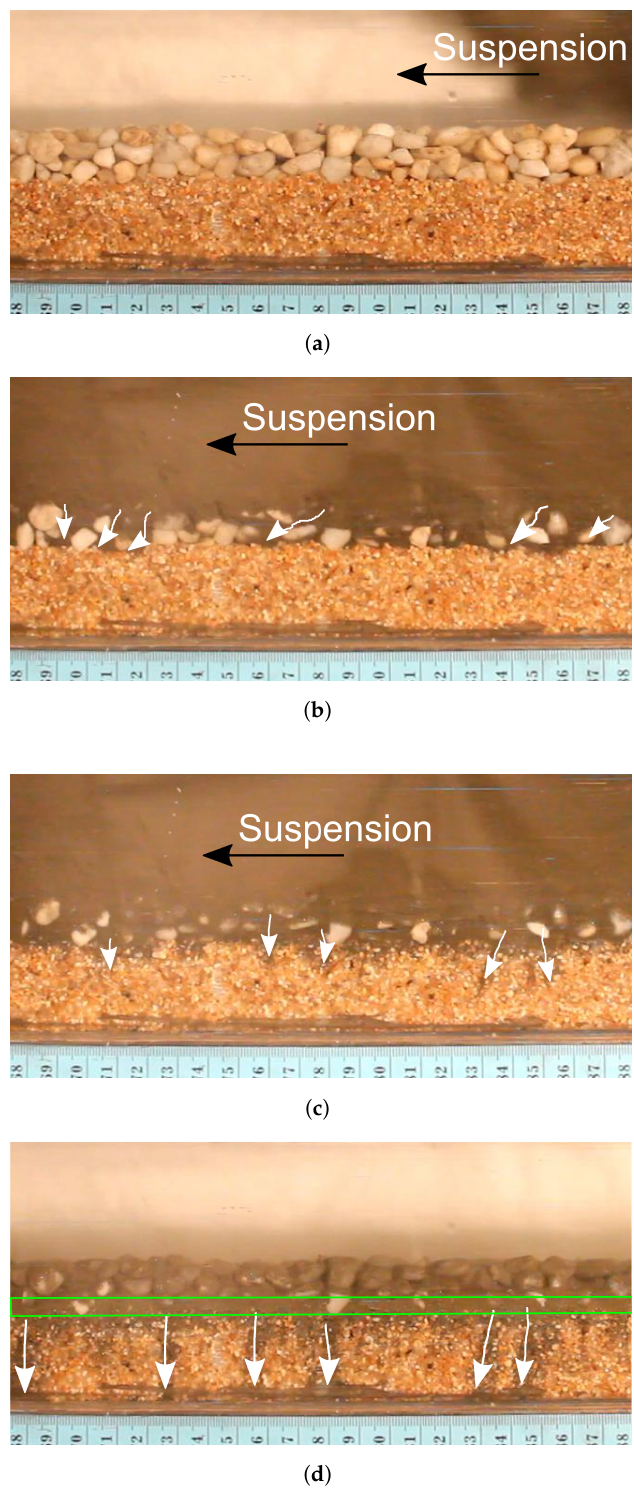
Figure 3. Copper concentrate transport dynamics in F1, experiment 7-F1. Images were taken from the sidewall. ( a ) Suspension transport of copper concentrate t = 0 s; ( b ) White arrows show that copper concentrate begins to infiltrate the gravel layer t = 2 s; ( c ) White arrows show that the copper concentrate begins to infiltrate into the sand substrate t = 4 s; ( d ) The green box shows the maximum zone of copper concentrate deposition and white arrows represent unimpeded static percolation. Final state with unimpeded static percolation and